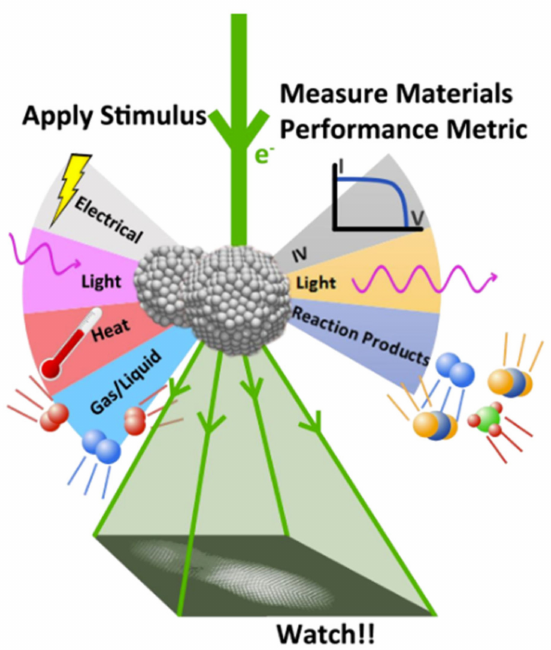
Figure 22. In-situ S/TEM involves direct specimen observation while applying stimuli, and operando S/TEM includes measuring a performance metric of the material [184]. Reprinted from Controlled Atmosphere Transmission Electron Microscopy, Spectroscopy of Solids, Gases, and Liquids in the ETEM, Crozier, Peter A., and Benjamin K. Miller, 2016, 95–141, Copyright (2016), with permission from Springer International Publishing Switzerland